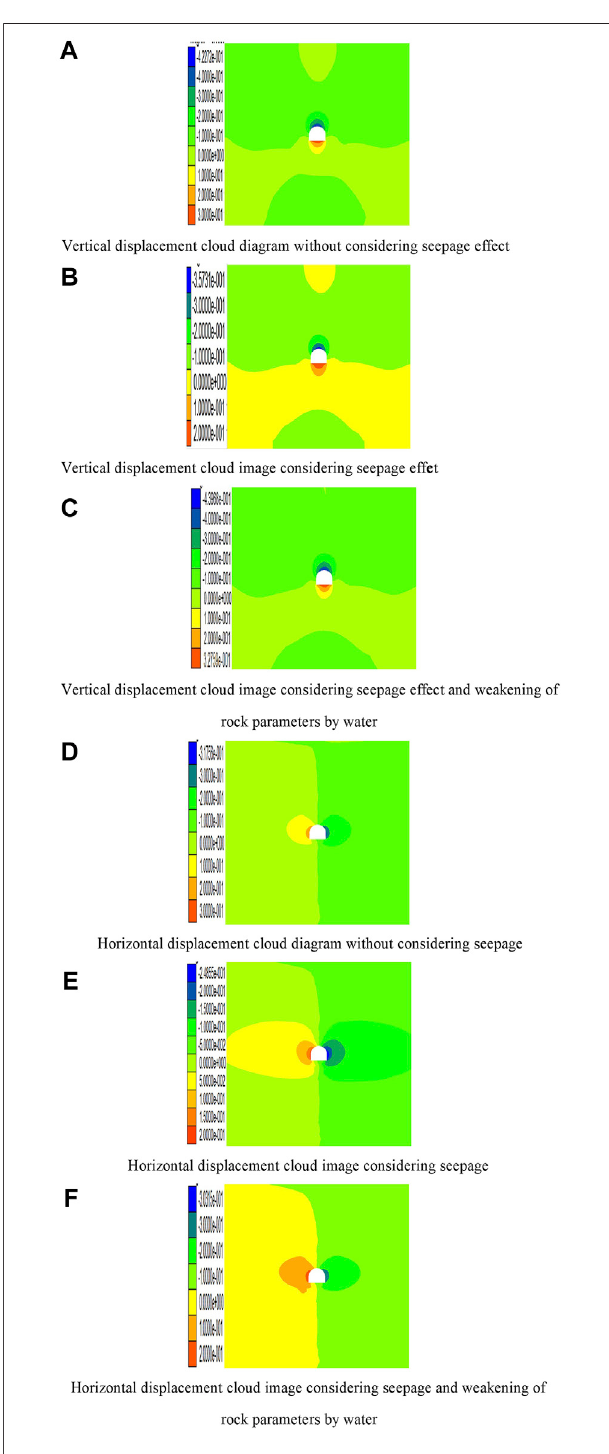
FIGURE 5 | Vertical and horizontal displacement nephogram of three different situations. (A) Vertical displacement cloud diagram without considering the seepage effect. (B) Vertical displacement cloud image considering the seepage effect. (C) Vertical displacement cloud image considering the seepage effect and weakening of rock parameters by water. (D) Horizontal displacement cloud diagram without considering seepage. (E)